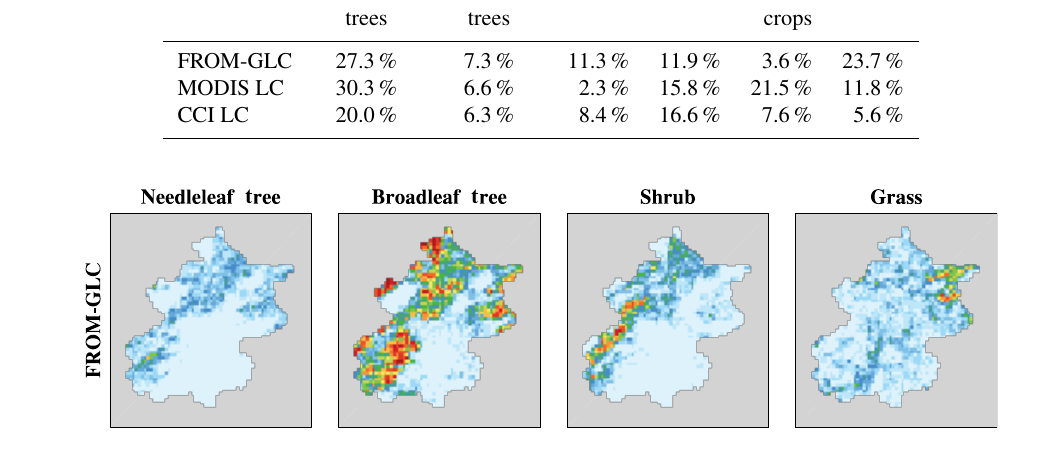
Table 3. The area fractions of different plant functional types (PFTs) in Beijing from the three land cover datasets. Broadleaf Needleleaf